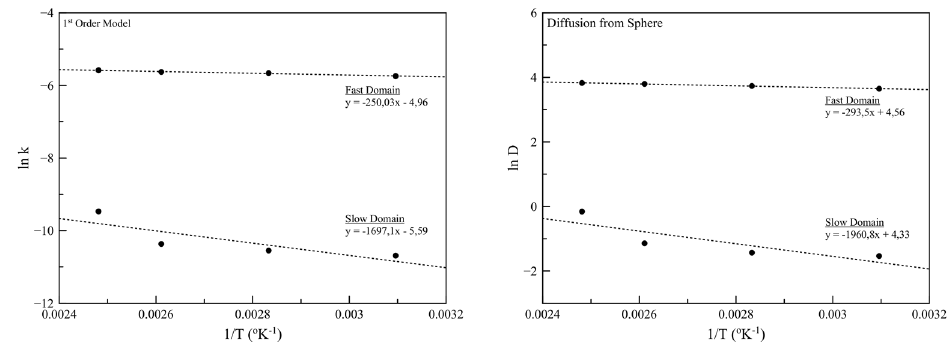
Figure 11. Plots of the natural logarithm of k and D values ( ln k and ln D, respectively) against 1/T, used for the activation energies calculation for the case of 1st order and the diffusion from sphere model, respectively.